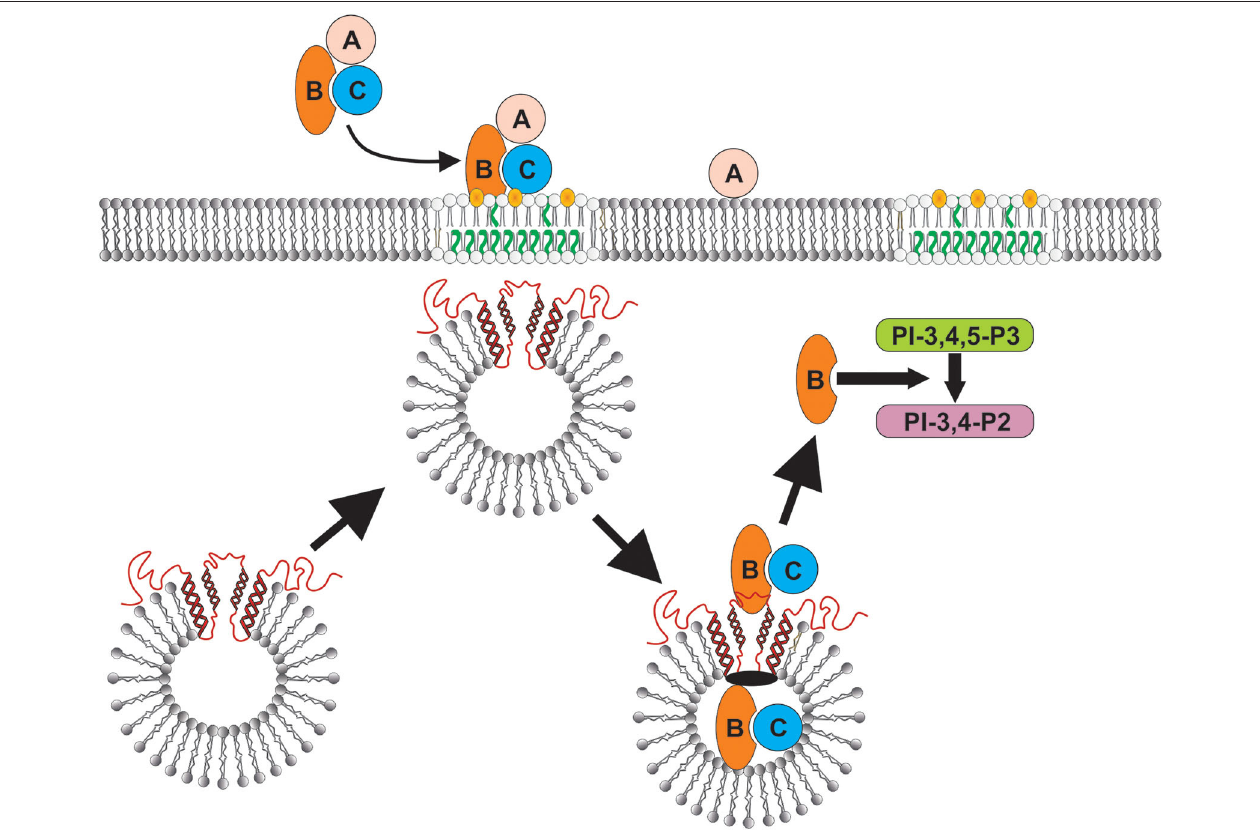
FIGURE 6 | Schematic model showing proposed CdtB-cellugyrin interaction. Cdt holotoxin binds to cells via cholesterol in the context of membrane lipid rafts. CdtB internalization is further dependent upon its ability to interact with cholesterol. As a result of exposure to Cdt, cellugyrin (shown in red) containing SLMVs translocate from cytosol to membrane lipid rafts. We propose that this translocation leads to association of CdtB with the cellugyrin-containing SLMVs. This interaction may involve direct binding to cellugyrin either on extra- or intra-vesicular loops or indirect association via an unidentified binding partner (shown in black). We further propose that CdtB is transported via SLMVs to intracellular target sites; for example sites containing PIP3 pools where the enzymatically active CdtB subunit is released from SLMVs and is then able to degrade the signaling lipid resulting in PI-3K blockade and